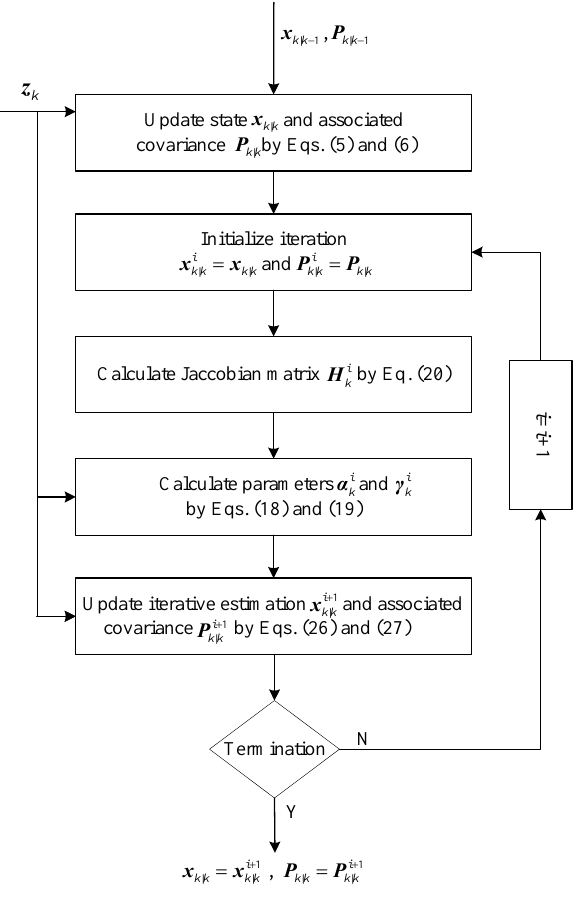
Figure 1. The flow diagram of the proposed PEKF-VB